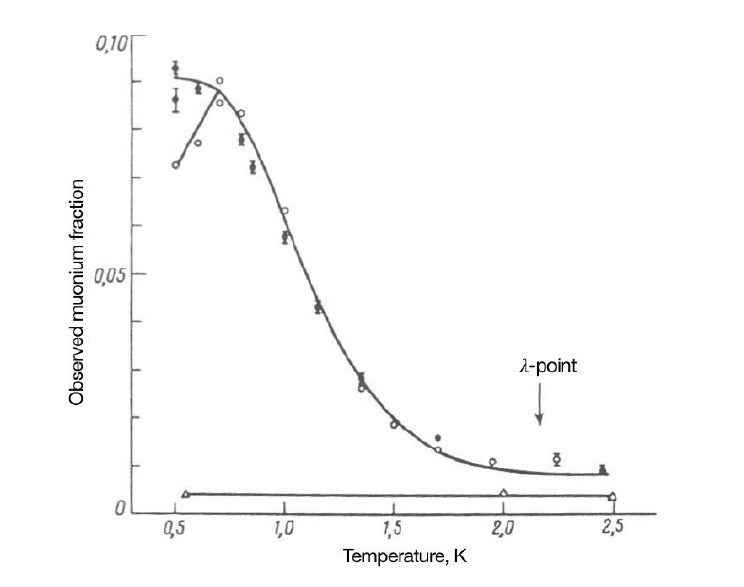
Figure 6. Muonium production vs. temperature in liquid helium (from [76]); open circles are results in pure 4 He, filled circles, 4 He + 0.2% 3 He, and triangles, pure 3 He. (Quantity plotted is observed muon decay asymmetry; an observed asymmetry of 0.105 corresponds to 100% muonium